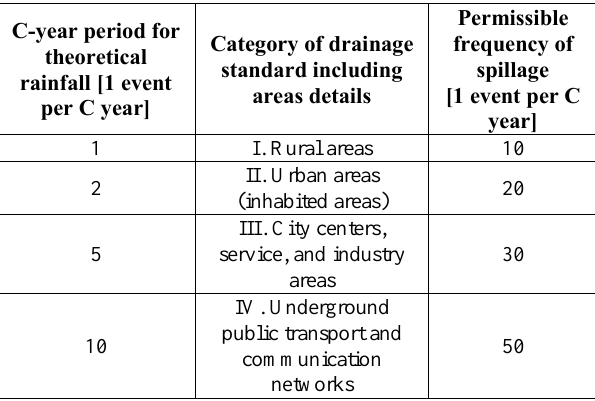
Table 1. Recommended design rainfall frequency and acceptable spillage rates according to PN-EN 752: